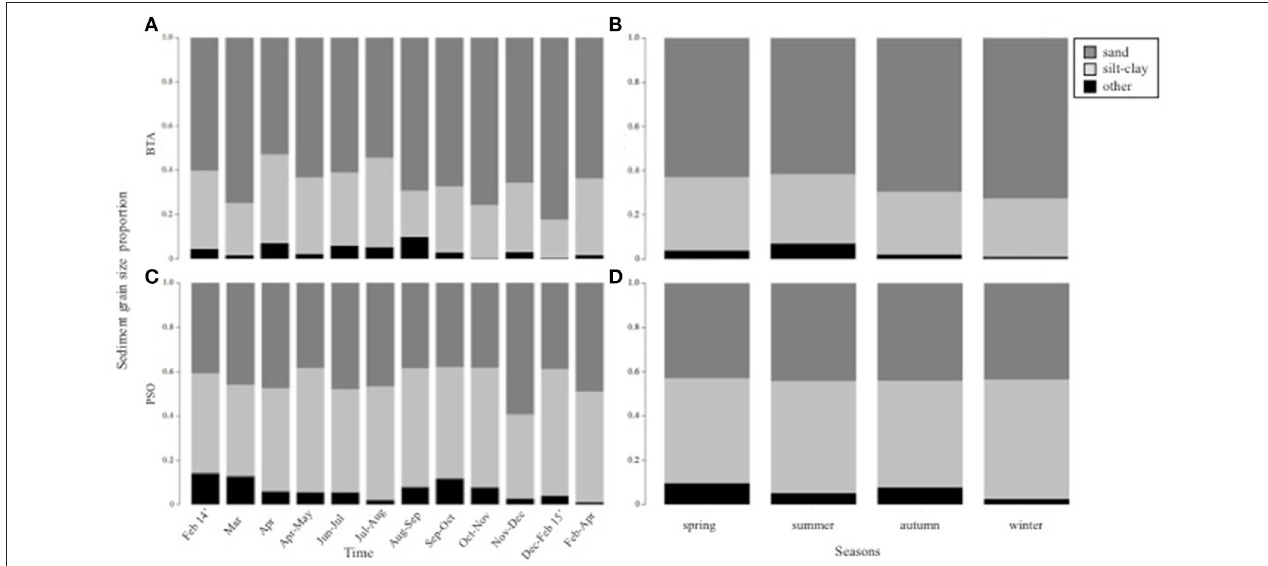
FIGURE 5 | Patterns of variation in sediment grain size proportion by time and season at BTA (A,B) and PSO (C,D) . Dark gray stacked bar: sand, light gray: silt-clay, and black: